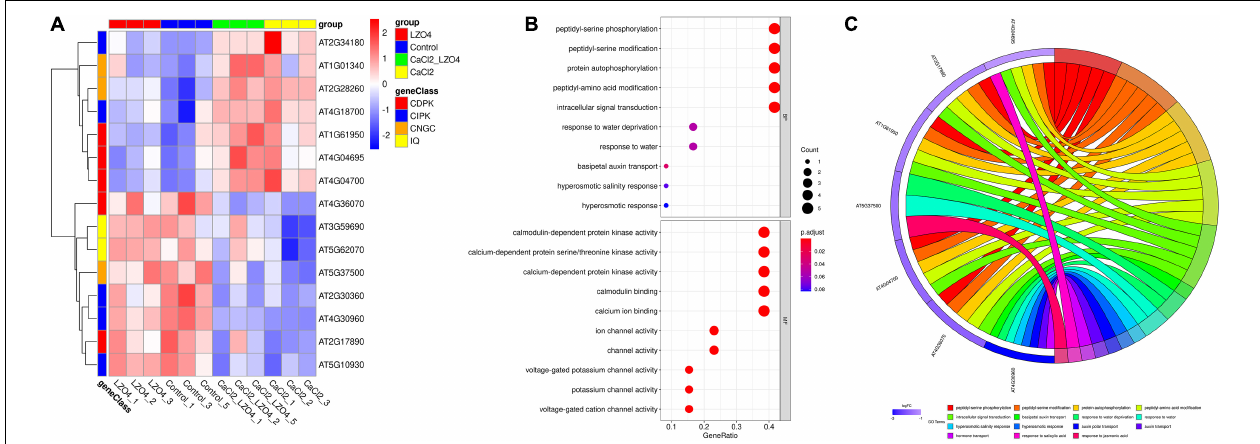
FIGURE 9 | Differential expression analysis and functional enrichment analysis of genes in calcium-related gene families in the whole root of A. thaliana . (A) The expression profiles of DEGs in calcium-related gene families in whole root of A. thaliana were shown in a heatmap. (B) The biological function (BP) and molecular function (MF) of DEGs associated with calcium. (C) The GO enrichment of DEGs in calcium-related gene families. The top 15 terms (sorted by p.adj.value ) were shown in the circos plot. The top 10 terms of the GO and KEGG results (sorted by p .ajd.value) were selected for visualization. The size and color of the dots were proportional to the number of genes and the p.adj.value , respectively.